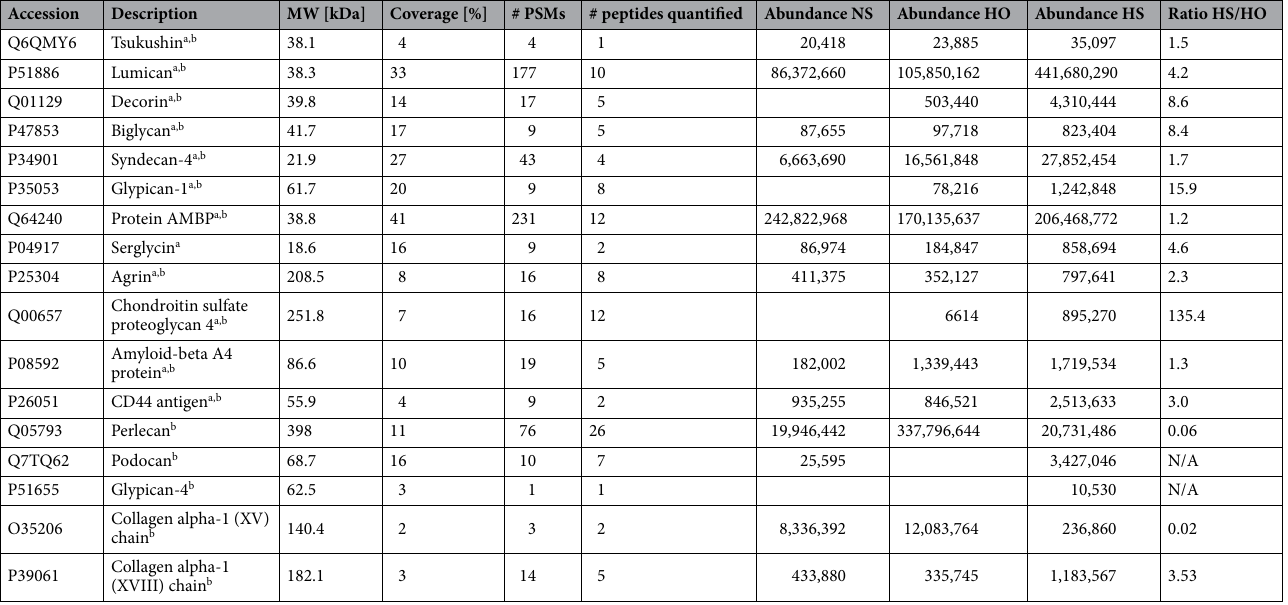
Table 2. Proteoglycans identified in renal eluates from rats using the Swiss-prot rat and mouse database, respectively. The reported abundances were calculated based on the peptides quantified, normalized to total amount of peptides. a Identified searching the proteomics data against the Swiss-Prot rat database. b Identified searching the proteomics data against the Swiss-Prot mouse